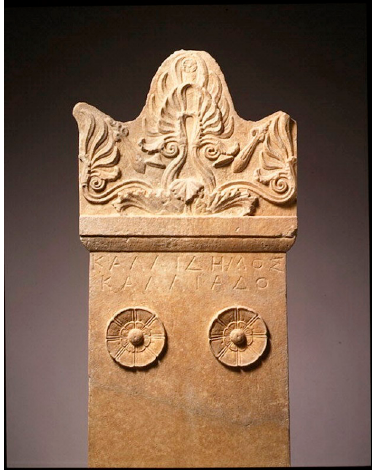
Figure 24. New York, Metropolitan Museum of Art 25.78.30 Upper portion of the Attic marble stele of Kallidemos topped by a double palmette flanked by two half-palmettes, all rising from spiral tendrils emerging from an acanthus calyx, ca. 350–325 B.C. Image © The Metropolitan Museum of